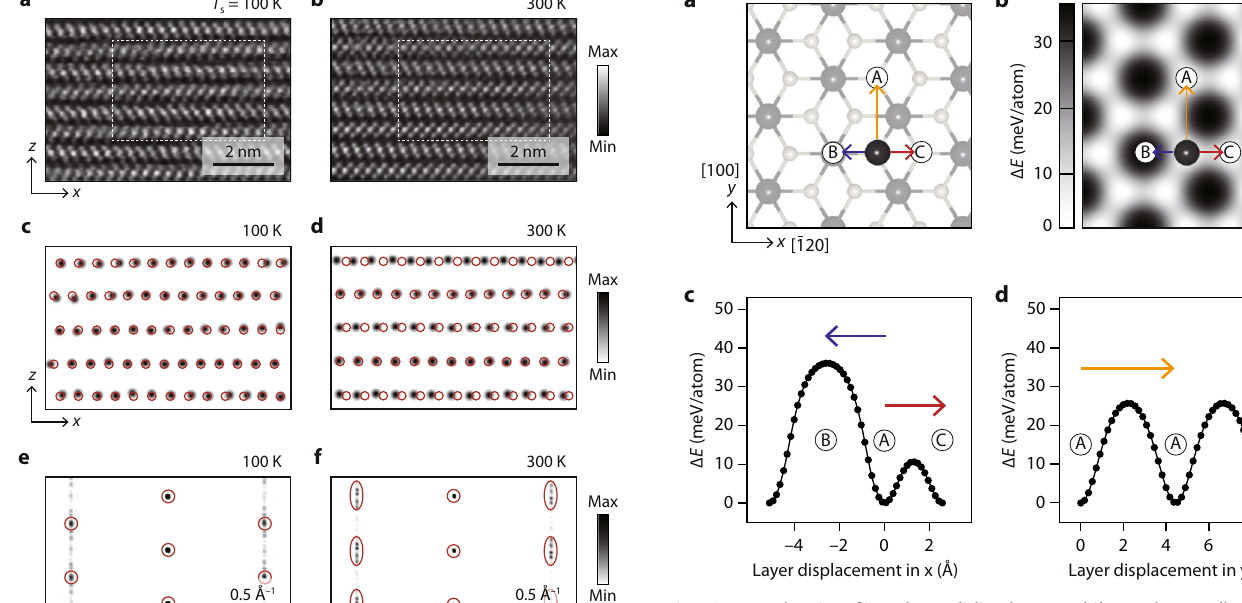
Fig.4 |EnergybarrierofinterlayerslidingbetweenbilayerPbI 2 .a Ball-and-stick modelofbilayerPbI 2 shownfromthetopview.Forclarity,thelowerlayerisshaded, and only one Pb atom in the upper layer (black ball) isshown. b Calculated energy differenceofdisplacing the upperlayerwith respecttothe lowerlayerand plotted over the same area asin a . The circled A,B, and C show the high-symmetry sites in the lower layer, as de fi ned in Fig. 1a. Red, blue, and yellow arrows indicate 3 representative sliding directions as introduced in a . c , d Energy difference plotted asafunctionofthelayerdisplacement( c )alongblueandredarrows,and( d )along yellow arrow. Source data are provided as a Source Data fi